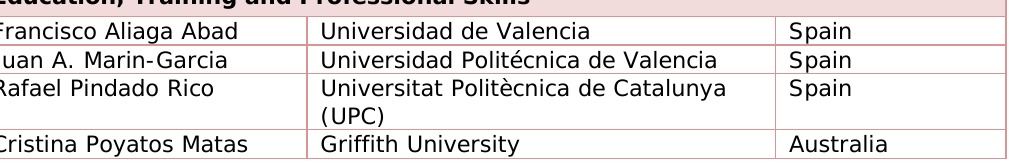
Name Afiliation